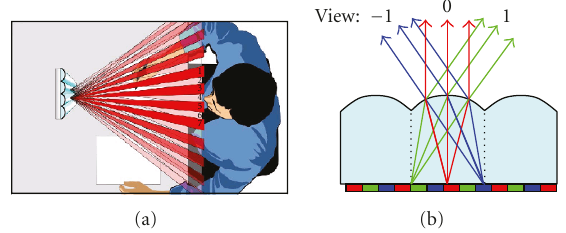
Figure 2: (a) The spatial multiplexing of the di ff erent views. (b) The light of the subpixels is directed into di ff erent directions by the lens [9].